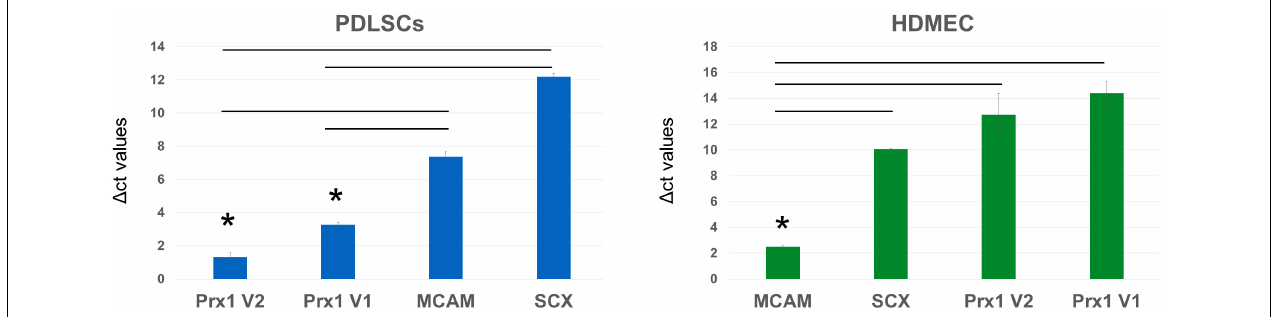
FIGURE 6 | Analysis of (cid:49) ct values of stem cell markers in PDLSC and HDMEC. Comparison of (cid:49) ct values of MCAM/CD146, Scleraxis, and PRX1 in human PDLSC and in human HDMEC. ∗ p <